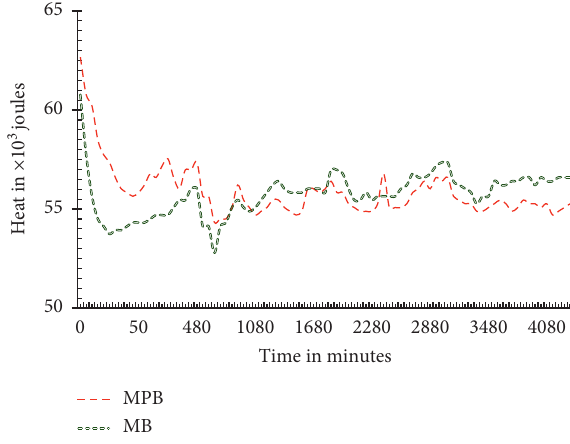
Figure 3: Heat measurement.